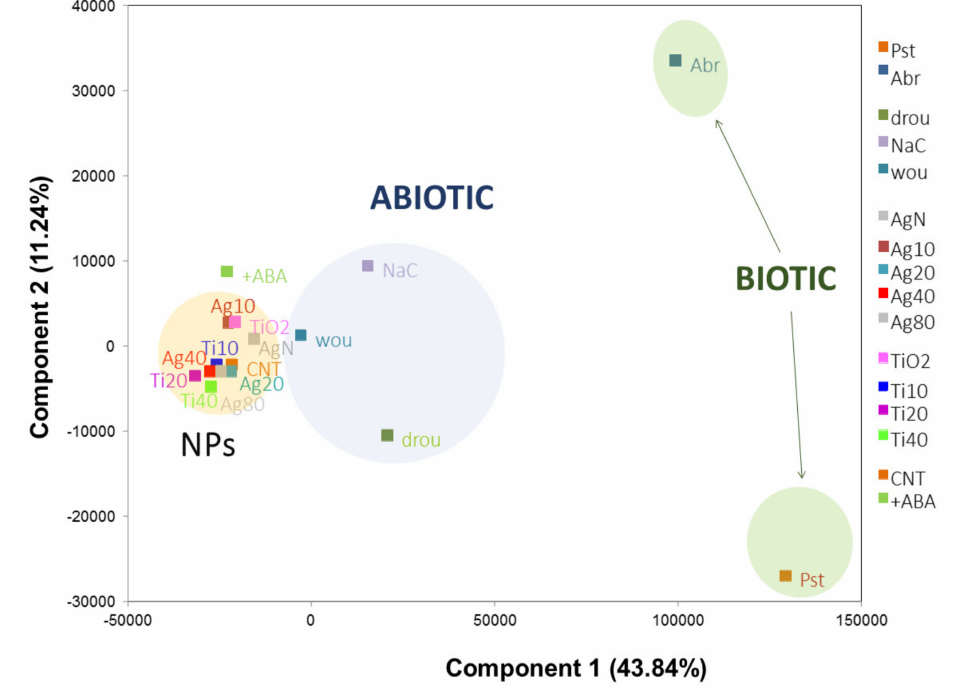
Figure 2. Principal Component Analysis of Arabidopsis microarray data performed by Garc í a et al. [34]. The first and second components of the analysis, which captured respectively 43.84% and 11.24% of the variation in data, were plotted to visualize similarities among samples. Plants were exposed to biotic stress by inoculation with the necrotrophic fungus Alternaria brassicicola ( Abr ) or the hemibiotrophic bacterium Pseudomonas syringae ( Pst ), and to abiotic stress by hypersaline conditions ( NaC ), drought ( drou ), or wounding ( wou ). For NP exposure, plants were grown in MS medium containing NPs made of 3 different materials -Ag, TiO 2, or carbonaceous nanotubes- and at different sizes in the nanoscale. Ag20 , Ag40 , Ag80 , and AgN represent the addition of Ag NPs of 10-, 20-, 40- and 80-nm diameter, or AgNO 3 bulk material, respectively. Ti10 , Ti20 , Ti40 , and TiO2 indicate the addition of TiO 2 NPs of 10-, 20-, 40-nm diameter, or TiO 2 bulk material. CNT indicates the addition of carbon nanotubes. Since Abscisic Acid (ABA) hormone is a key regulator of abiotic stress responses, exogenous addition of ABA ( +ABA ) was assayed to test for remediating effects on CTN-exposed plants. Transcriptomic data are available at www.ebi.ac.uk/arrayexpress under the accession number